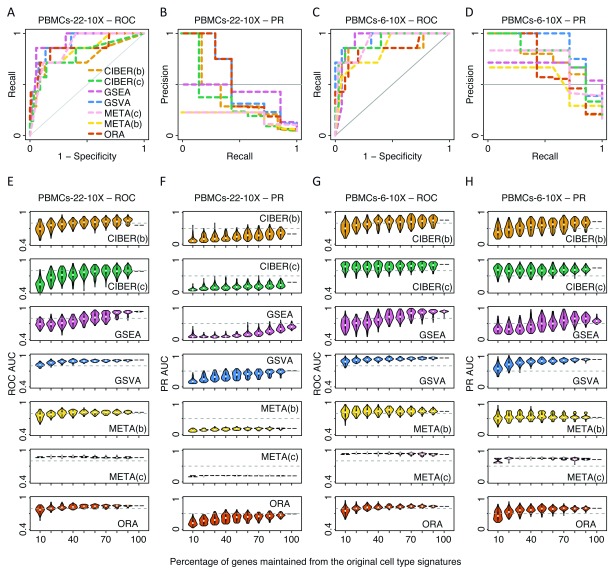
Performance and robustness analysis of cell type prediction methods using 10X PBMCs scRNA-seq data.The same procedure as described in
Figure 2 for ROC and PR AUCs of the liver and retinal neuron datasets was used here for the PBMCs dataset measured with the 10X Chromium technology. Please see
Figure 2 legend for details. Seven cell clusters from the 10X scRNA-seq measurements could be mapped vs. six out of 22 cell types of the PBMC LM22 matrix signatures. This dataset was analysed in two ways. In the first way (‘PBMCs-22-10X’, panels
A,
B,
E and
F), all 22 cell type signatures from the LM22 matrix were used as input for cell type prediction methods. In the second way (‘PBMCs-6-10X’,panels
C,
D,
G and
H), only the six cell types from the LM22 that could be mapped to the seven cell clusters were used as input for cell type prediction methods. For CIBERSORT and METANEIGHBOR, two approaches were used, one with the original LM22 matrix with continuous gene expression values, that we called CIBERSORT ‘continuous’ (CIBER(c)) and METANEIGHBOR ‘continuous’ (META(c)), and another with a thresholded and binarized version of the LM22 matrix, that we called CIBERSORT ‘binary’ (CIBER(b)) and METANEIGHBOR ‘binary’ (META(b)).